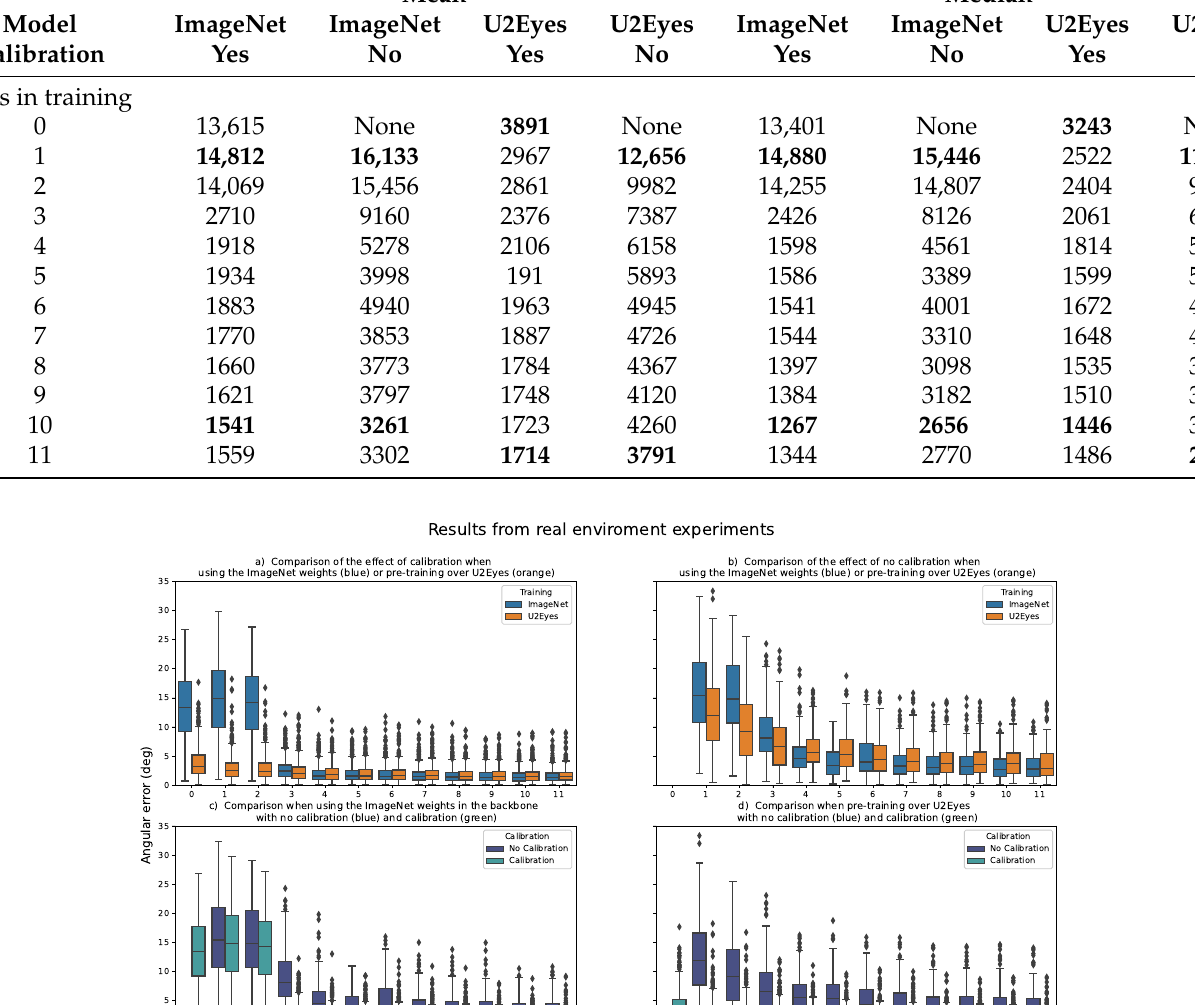
Table 5. Results from the different experiment configurations. Mean and median angular errors in degrees are shown for each case. The number of users in training represent the number of subjects that participate during the training that are not test users. The maximum and minimum values for each one of the columns are emphasized. Mean Median Model